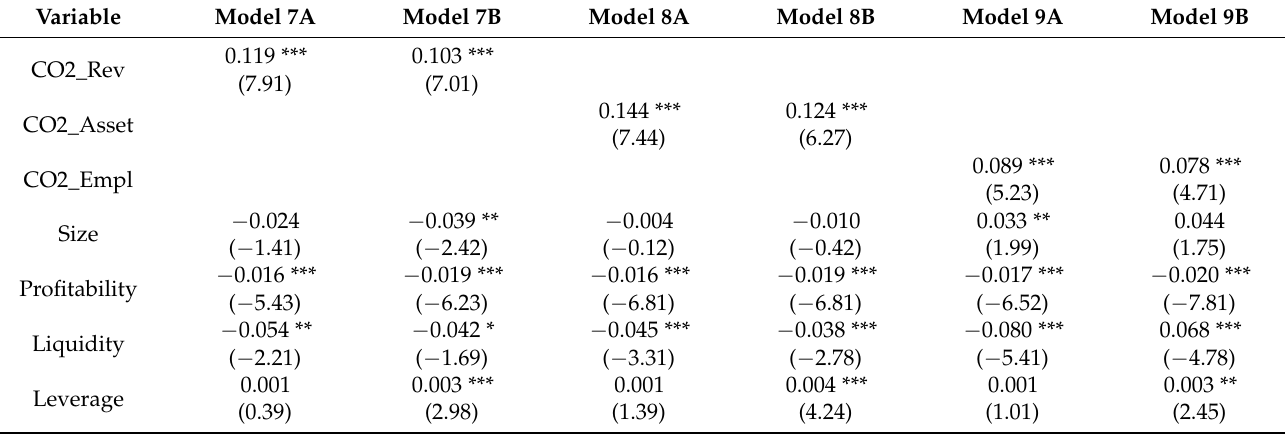
Table 6. The estimation results of regression models with industry dummy